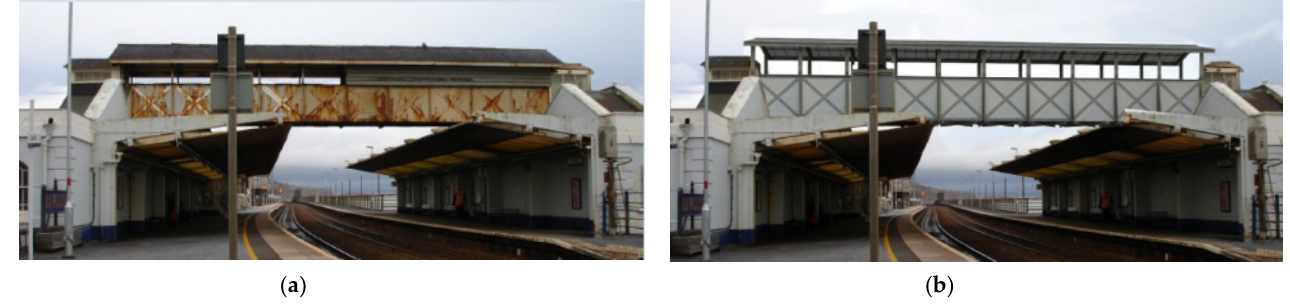
Figure 4. Dawlish pedestrian bridge Exeter UK: ( a ) Old rusty steel bridge, 1937 [47]; ( b ) New FRP bridge, 2011 [47].